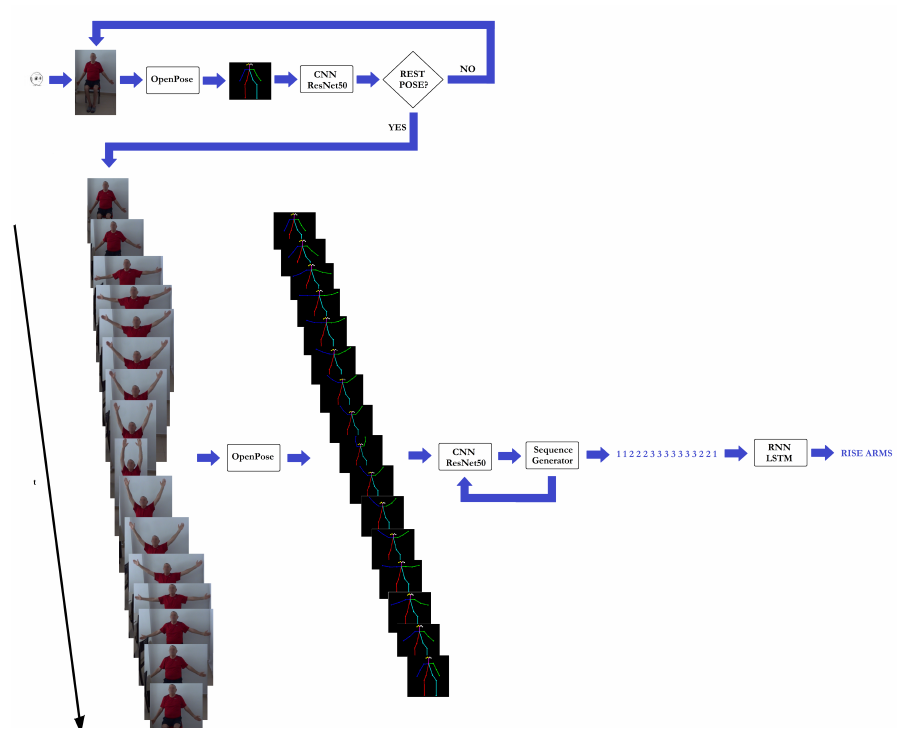
Figure 6. Architecture used for visual exercise